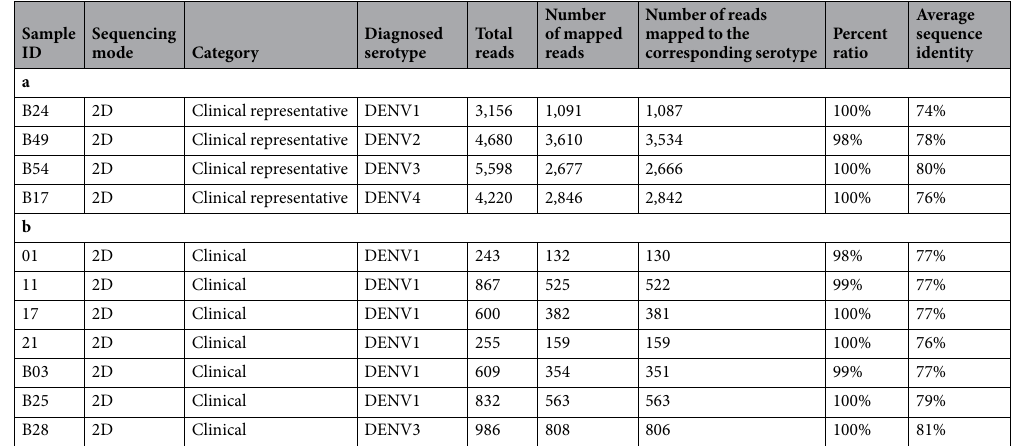
Table 2. Serotyping clinical samples. The number and percentage of the sequence reads supporting the indicated serotypes are shown in the seventh and eighth columns, respectively, for the indicated clinical samples. The average sequence identification was calculated based on the alignments and is shown in the last column. Shown here are results from the representative samples for DENV1 to DENV4 ( a ) and random selection ( b